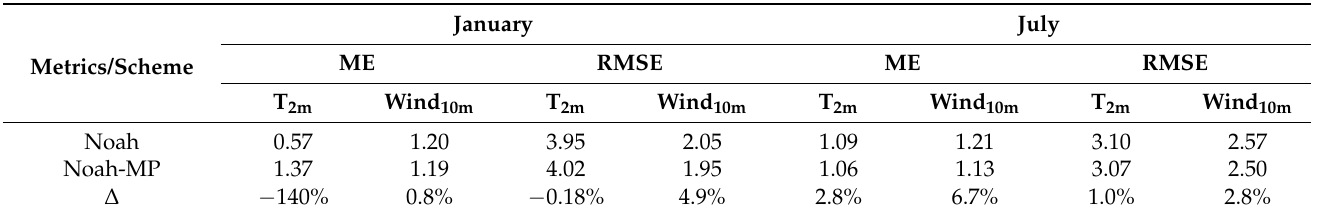
Figure 9. Differences of the monthly mean RMSE (RMSE Noah -RMSE Noah-mp ) of simulated 2-m air temperature (( a , c ), unit: ◦ C) and 10-m wind speed (( b , d ), unit: m · s − 1 ) between WRF simulations with Noah and Noah-MP scheme in January ( a , b ) and July ( c , d ) 2017. Table 5. ME and RMSE of simulated 2-m temperature (unit: ◦ C) and 10-m wind speed (unit: m · s − 1 ) with Noah and Noah-MP scheme in January and July 2017.